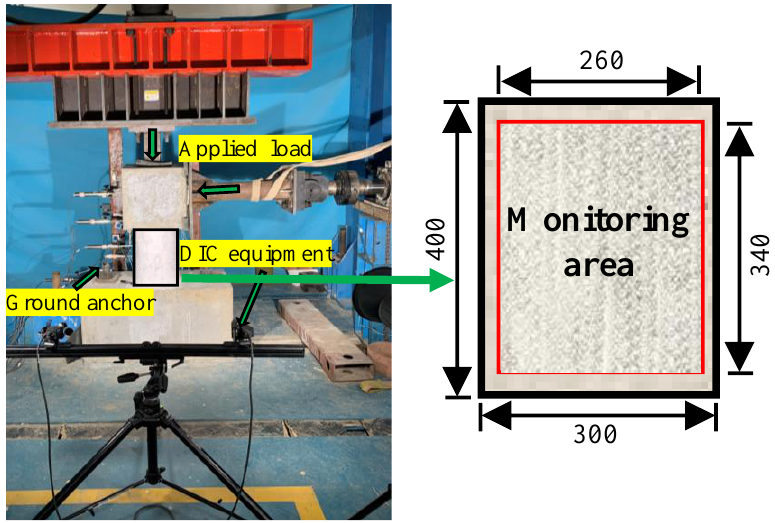
Figure 9. Loading configuration of test specimen.